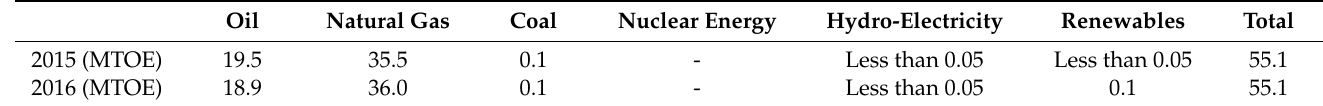
Table 4. Primary energy consumption by fuel between 2015 and 2016